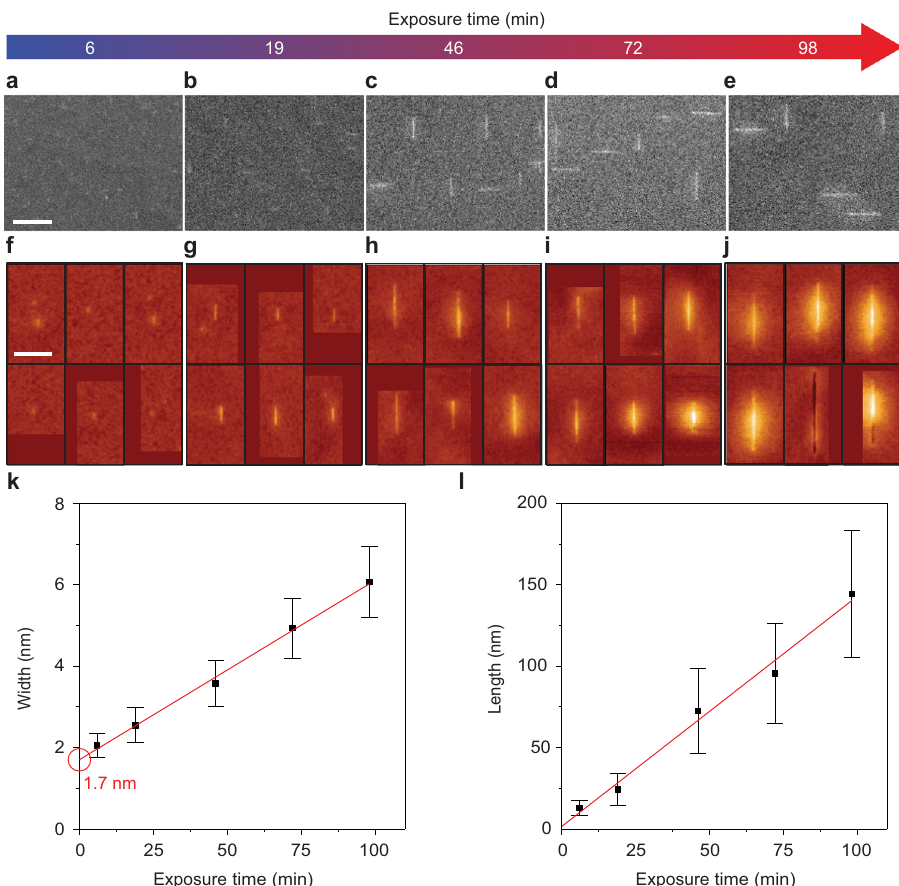
Fig. 2 Anisotropic evolution from PTCDA-derived seeds. a – e SEM images of nanoribbons after CH 4 exposure times of 6, 19, 46, 72, and 98 min. Scale bar is 200 nm. f – j STM images of nanoribbons after exposure times of 6, 19, 46, 72, and 98 min (applied bias = 2 V, tunneling current = 0.1 nA). Scale bar is 100 nm. Color is scaled to topographic height, with dark red being lowest and light yellow being highest. k , l Plots of width and length versus exposure time. Red lines are linear best fi ts. Red circle indicates where the linear fi t intercepts the y -axis and de fi nes the effective seed size of 1.7 nm. Error bars are standard deviation of width ( k ) and length ( l ).